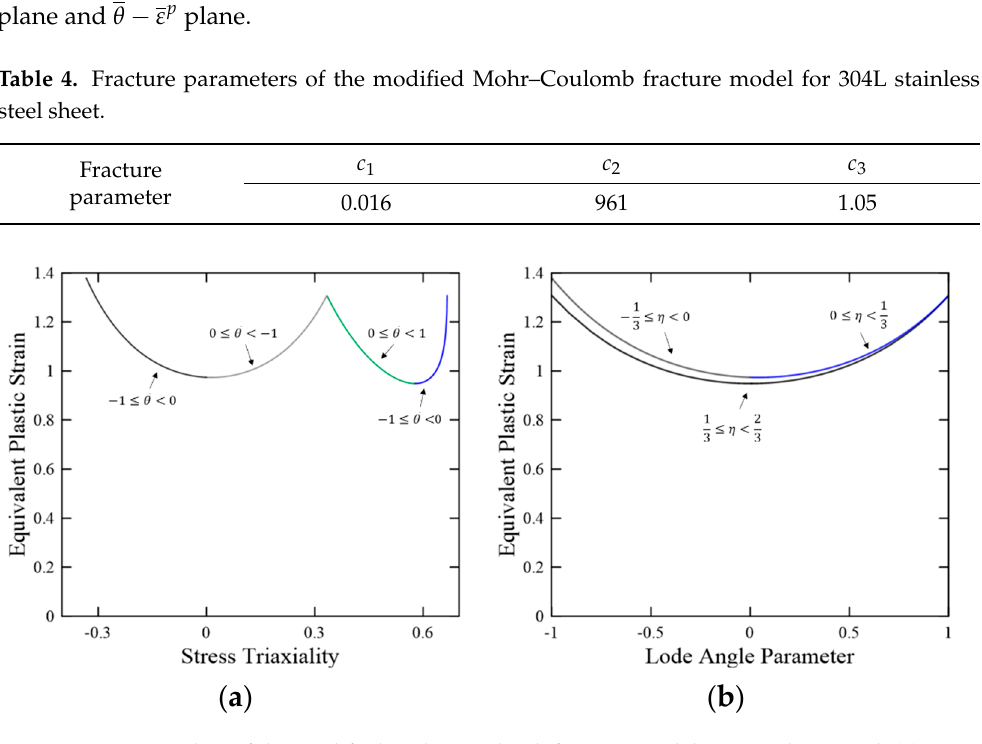
Table 3. Average stress triaxiality, average normalized Lode angle, and equivalent plastic strain at damage initiation of 304L stainless steel. The average values were derived considering the loading history.